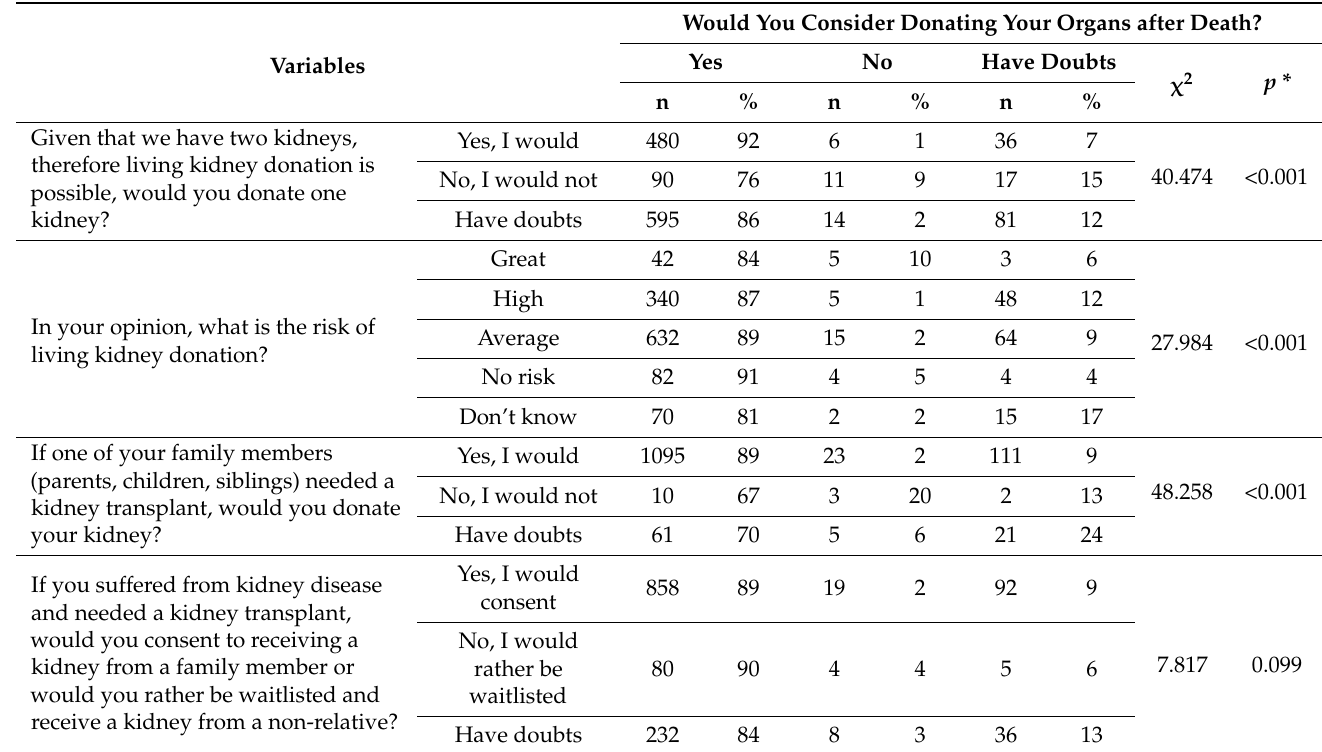
Table 5. The effect of selected variables on the answer to the question: “Would you consider donating your organs after